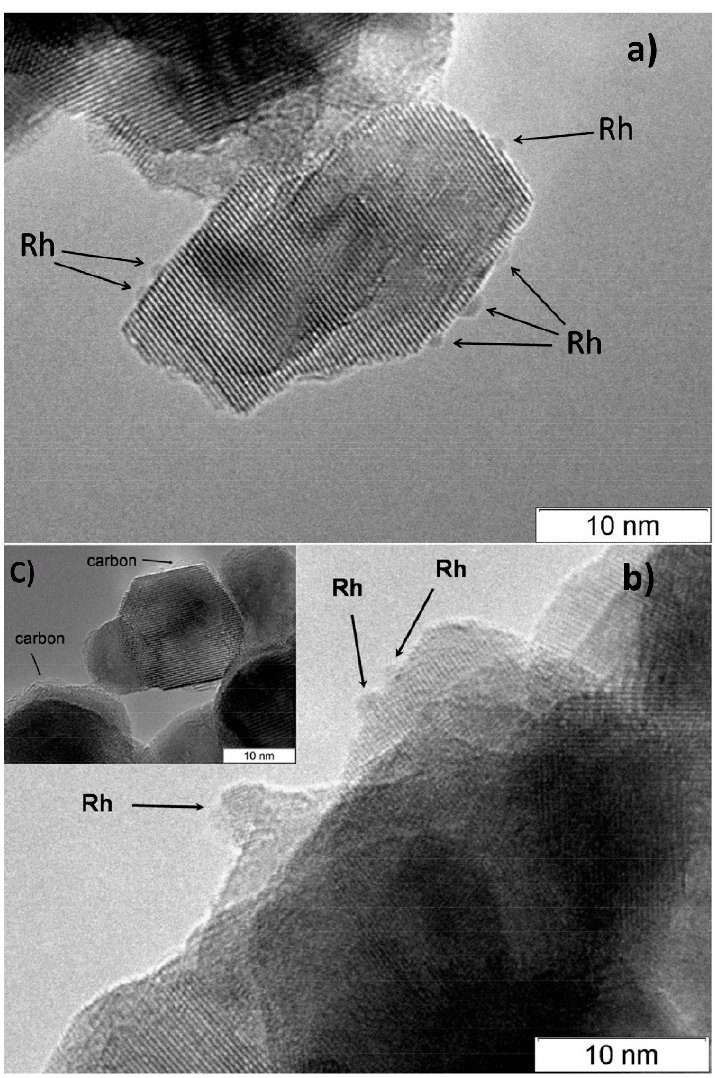
Figure 2. TEM images of 1 wt.% Rh/CZ: ( a ) as ‐ prepared and ( b , c ) used in HD ATR [49].